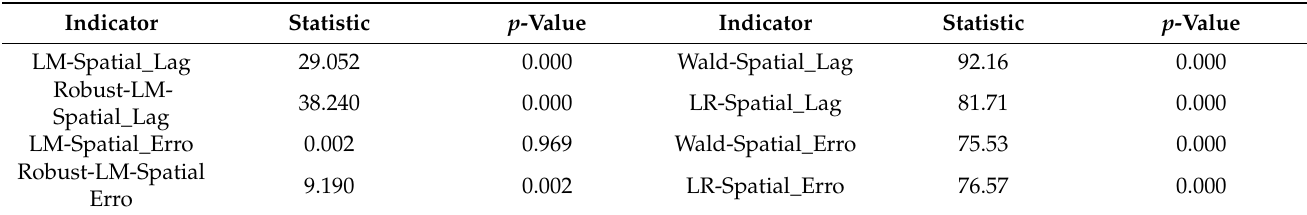
Table 5. Model selection.